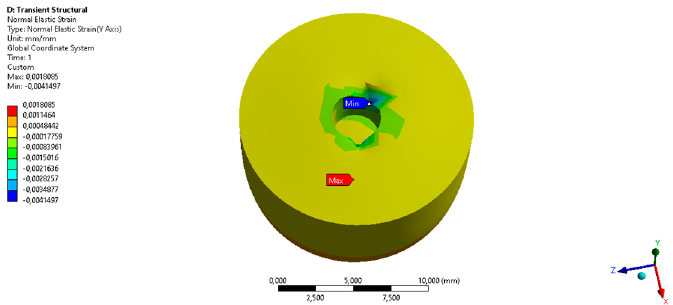
Figure 7. Thermal-Structural Analysis. Y-axis Normal elastic Strain 0.0018.